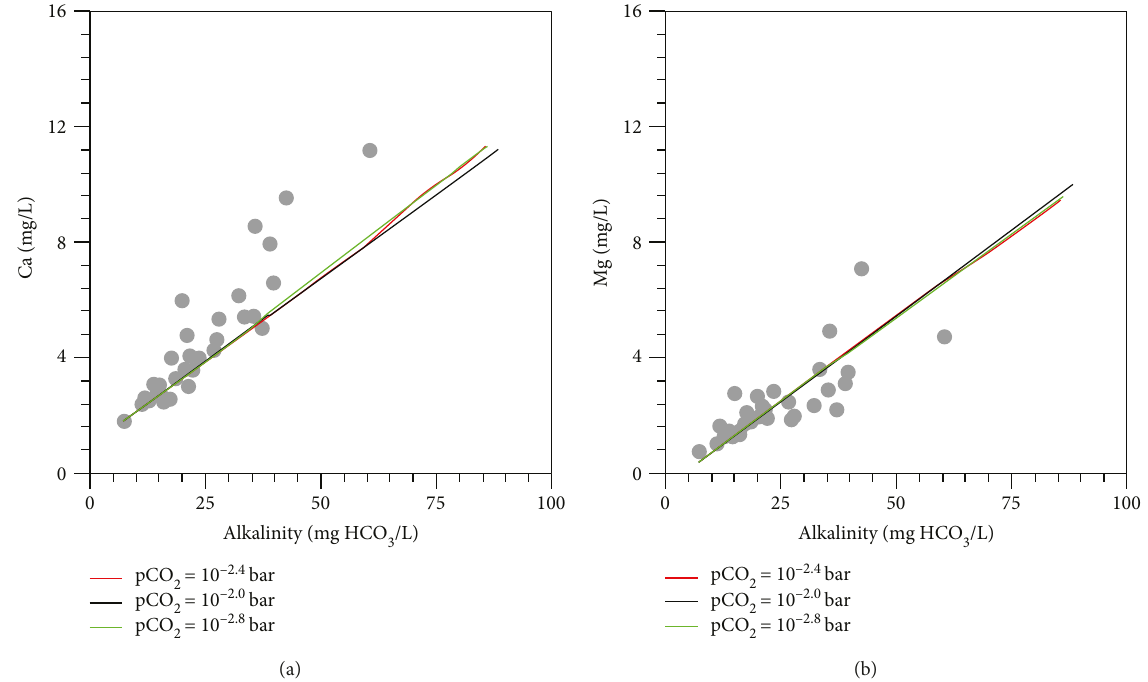
Figure 7: Plots of (a) Ca and (b) Mg vs. alkalinity showing the analytical data from groundwaters interacting with granulitic rocks of the lower crust as well as the results of reaction path modeling for granulite dissolution under di ff erent pCO